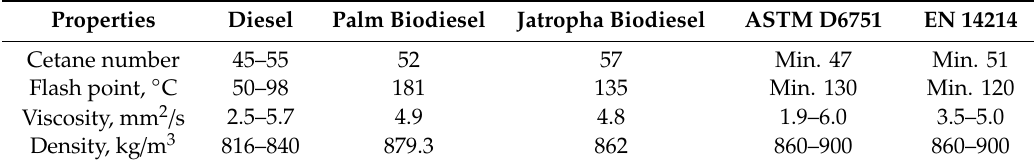
Table 1. Comparison of vegetable oil with biodiesel specification